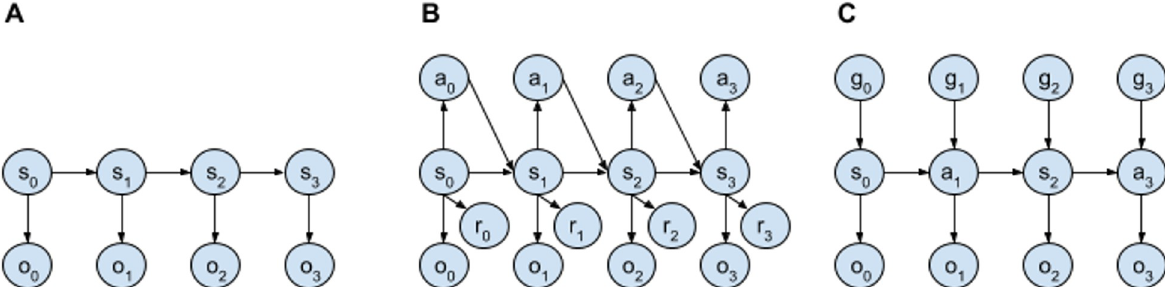
Fig 3. Graphical models of some probabilistic models usable to represent the dynamics of the world in planning systems. Nodes represent probability distributions and directional links represent conditional dependence between probability distributions. (a) Hidden Markov Models (HMMs): these are formed by state nodes ‘s’ and observation nodes ‘o’. (b) Partially Observable Markov Decision Processes (POMDPs): these are also formed by action nodes ‘a’ and reward nodes ‘r’ (different versions of these models are possible based on the chosen nodes and their dependencies). (c) The HMMs considered here, where the planner knows the currently pursued goal ‘g’ and observes not only states but also actions (note that the task considered here involves a sequence of independent state-action-state experiences).